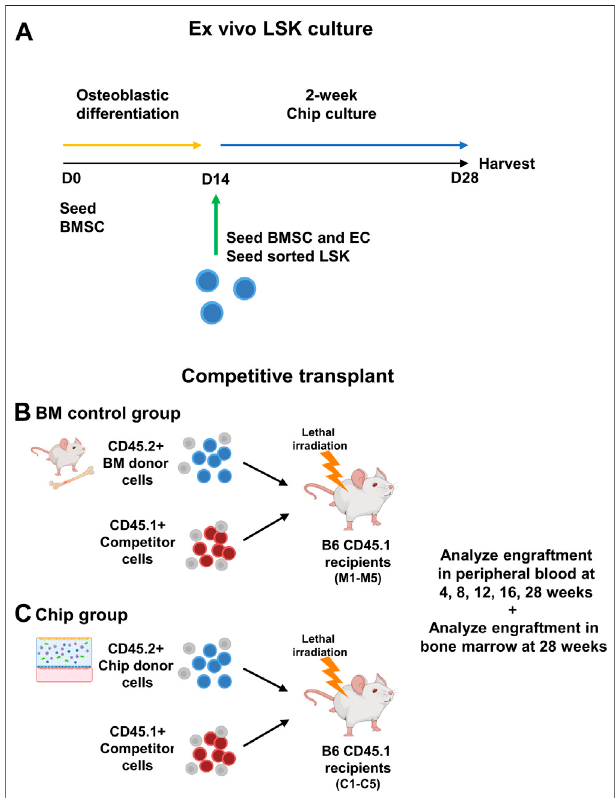
FIGURE 4 | Diagram of ex vivo culture of sorted LSK cells in BMME- on-chip and competitive transplant. (A) CD45.2+ LSK cells were sorted using fl ow cytometry and cultured with BMSC in hydrogel for 14 days in BMME-on-chip. (B) Functional analysis using competitive transplant assay of bone marrow and chip grown LSK CD45.2+ donor into recipient B6 CD45.1 (C) with CD45.1+ competitor cells. Illustrated using